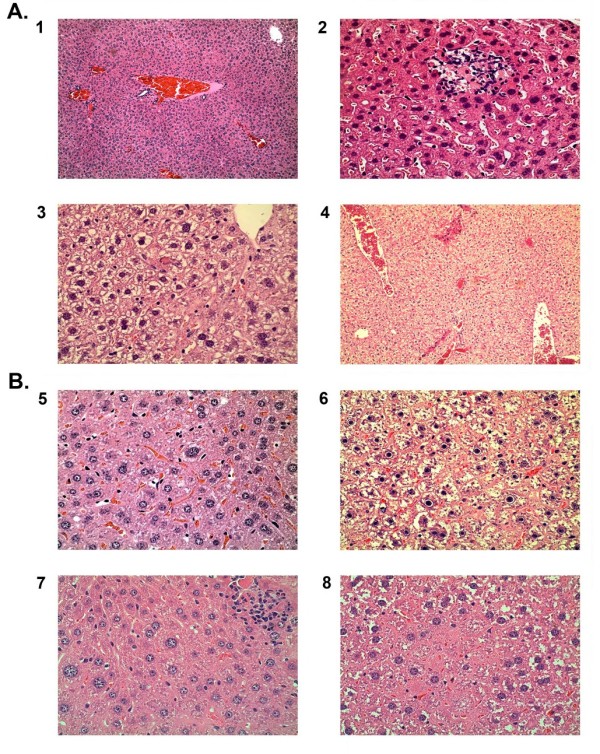
Effects of dietary supplementation with various compounds on histological analyses of livers of 8-week-old and 46-week-old C57BL/6 male mice: The scan 1-8 shows the histological evaluation of representative liver sections from mice fed commercial diets with and without quercetin (100 ppm), δ-tocotrienol (100 ppm), and dexamethasone (10 ppm) to 4-week-old and 42-week-old male C57BL/6 mice for 4 weeks. The livers of each mouse was processed as described in experimental section. A = 8-week-old mice: 1. control; 2. quercetin; 3. δ-tocotrienol; 4. dexamethasone; B = 46-week-old mice, 5. control; 6. quercetin; 7. δ-tocotrienol; 8. dexamethasone.